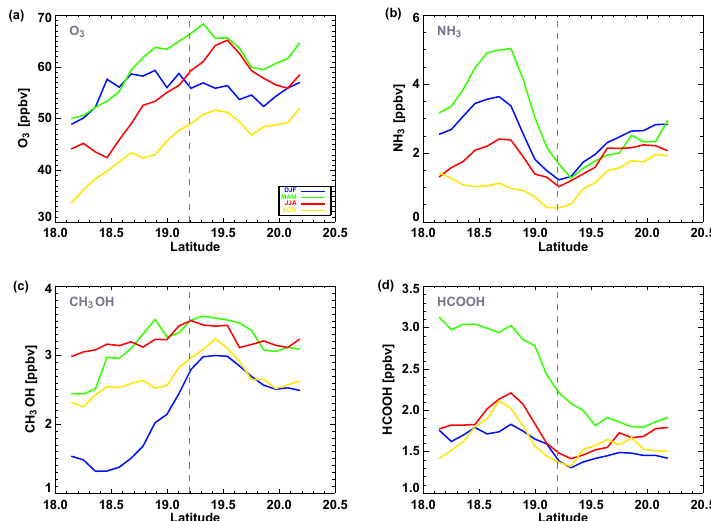
Figure 7. Seasonal means along the MCMA transect: O 3 (a) , NH 3 (b) , CH 3 OH (c) , HCOOH (d) .